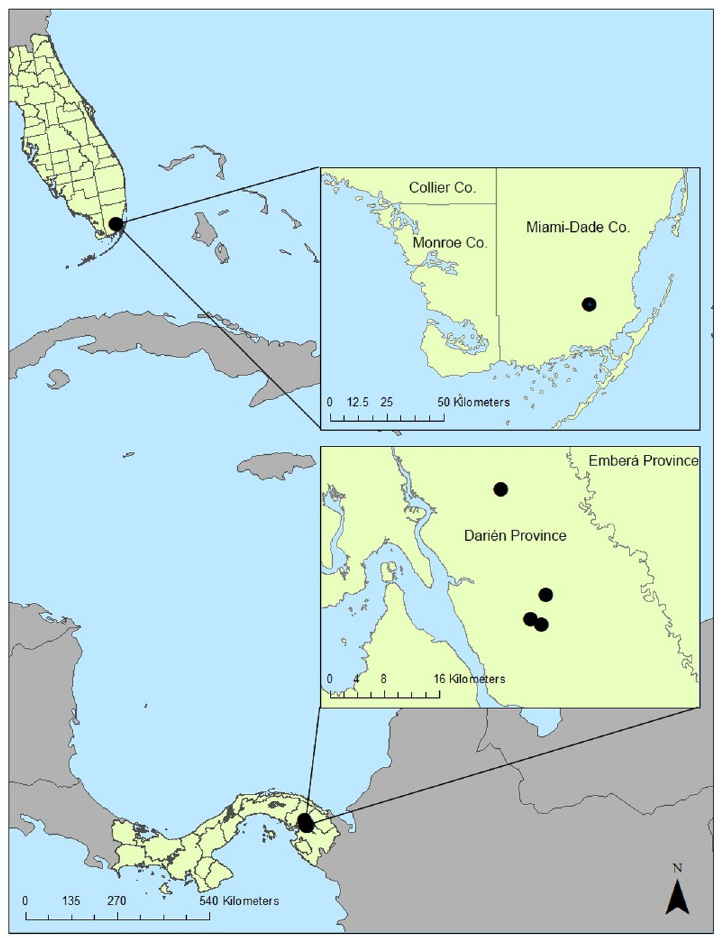
Fig 1. Map of the field sites in Florida City, FL, USA (1), and Metetı´, Darien Province, Panama (3). Base layer country maps downloaded from: